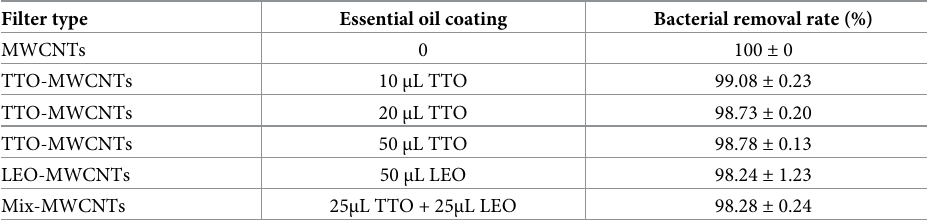
Table 1. Effect of essential oil TTO and LEO coating of MWCNT filters on bacterial removal